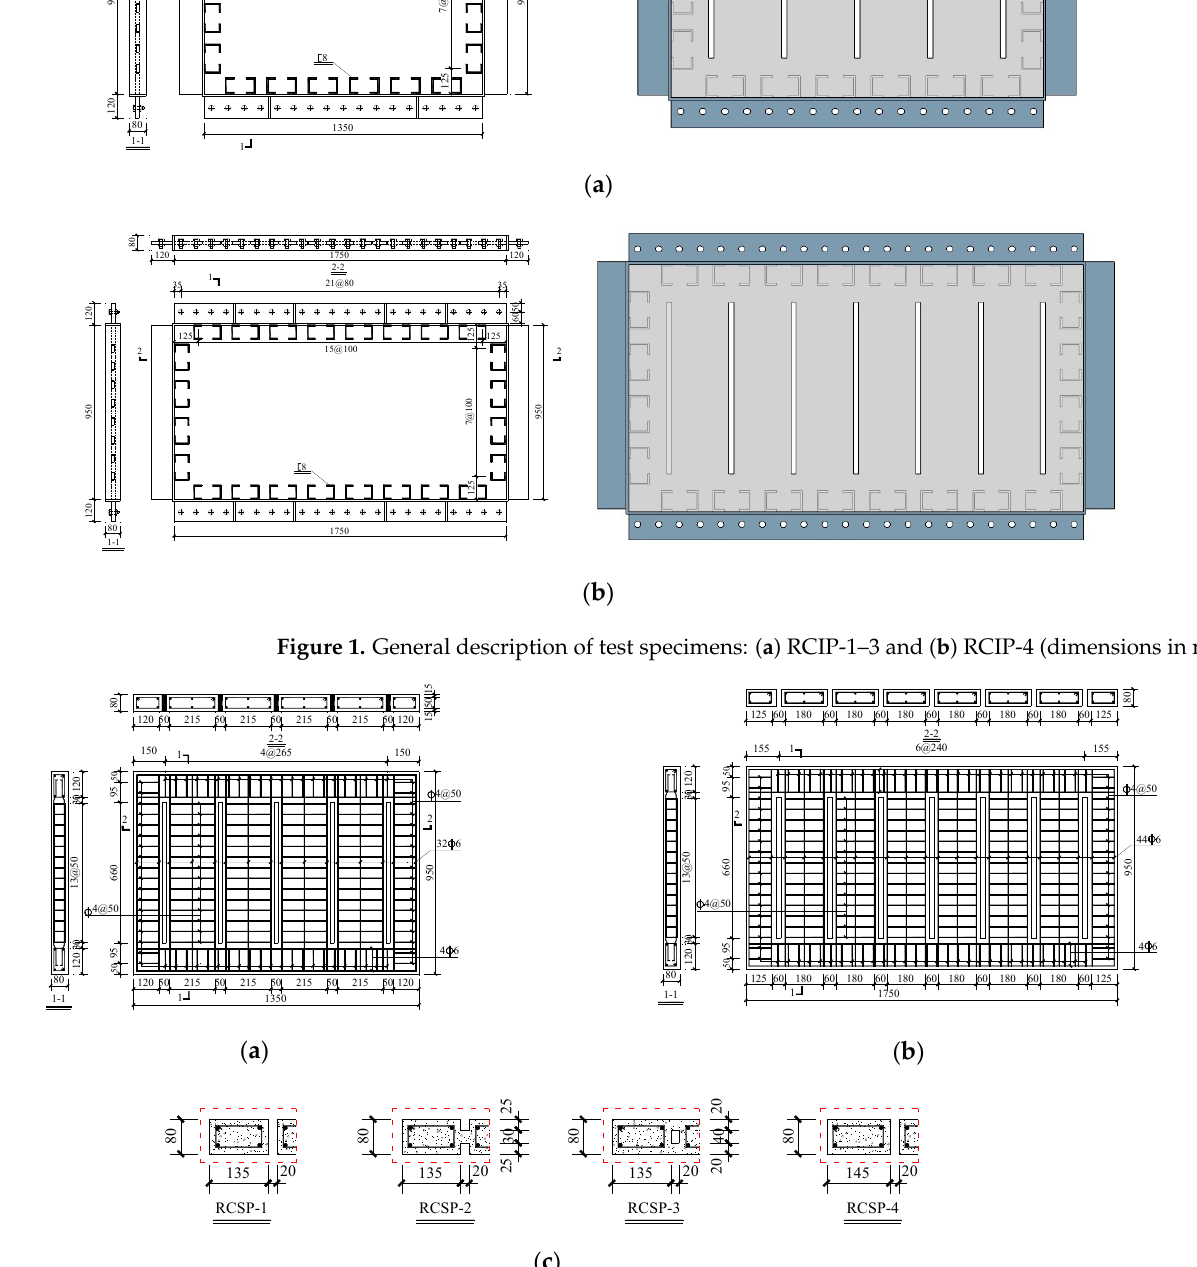
surrounding reinforcement cages. Figure 2 shows the dimensions and reinforcement details of the RC panels.